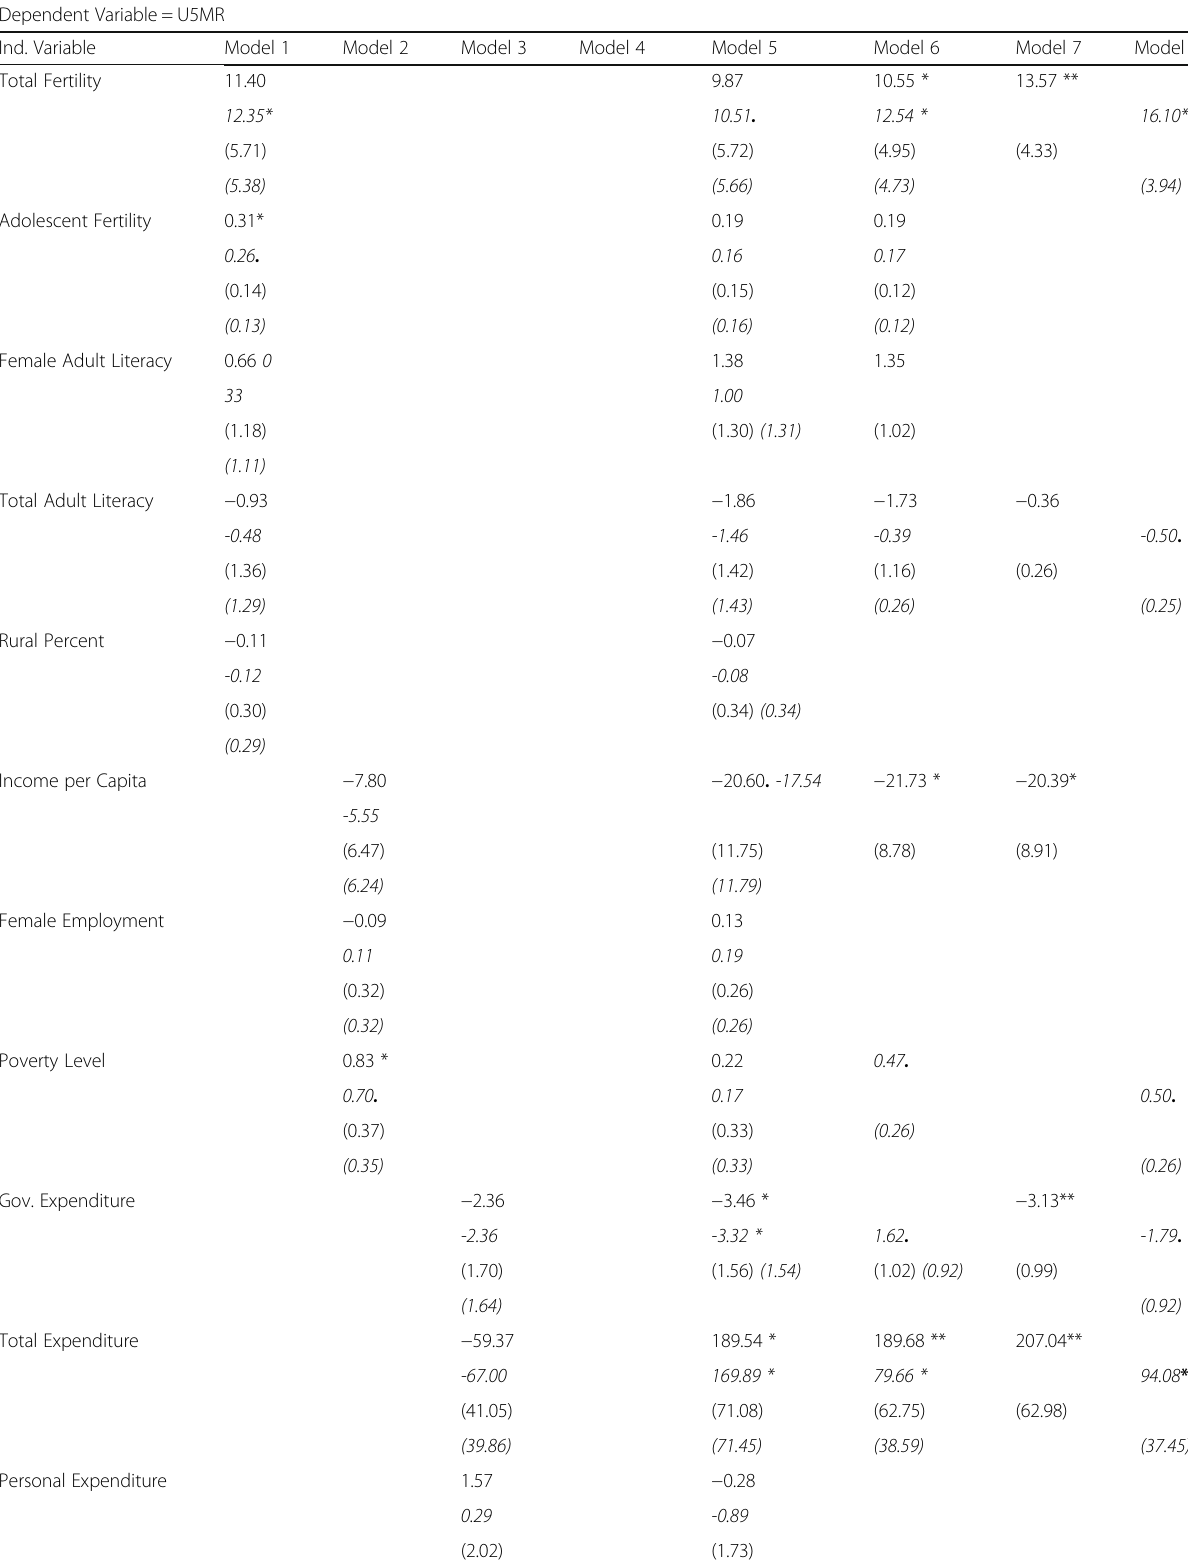
Table 5 Results for multivariate regression models with U5MR in 2010 as DV Dependent Variable =